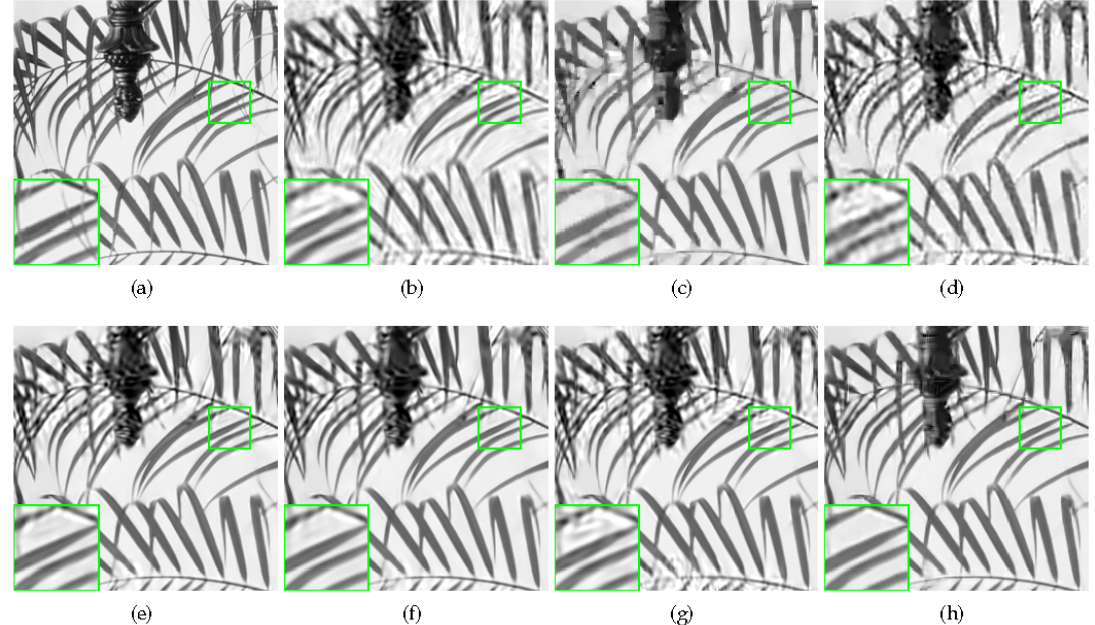
Figure 5. Reconstruction of Leaves with sampling rate = 0.1. ( a ) Original image; ( b ) MH (PSNR = 20.89 dB, FSIM = 0.7634); ( c ) RCoS (PSNR = 22.38 dB, FSIM = 0.8632); ( d ) ALSB (PSNR = 21.32 dB, FSIM = 0.7916); ( e ) GSR (PSNR = 23.22 dB, FSIM = 0.8755); ( f ) JASR (PSNR = 23.62 dB, FSIM = 0.8799); ( g ) GSR-NCR(PSNR = 22.26 dB, FSIM = 0.8408); ( h ) Proposed HNLSR (PSNR = 24.54 dB, FSIM = 0.8984